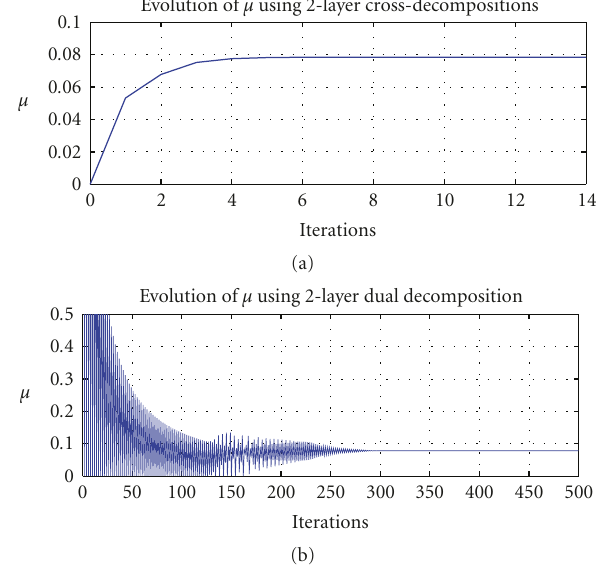
Figure 8: Evolution of μ value in the flow allocation subproblem. Comparison between a classical dual decomposition strategy and the proposed coupled-decompositions method.